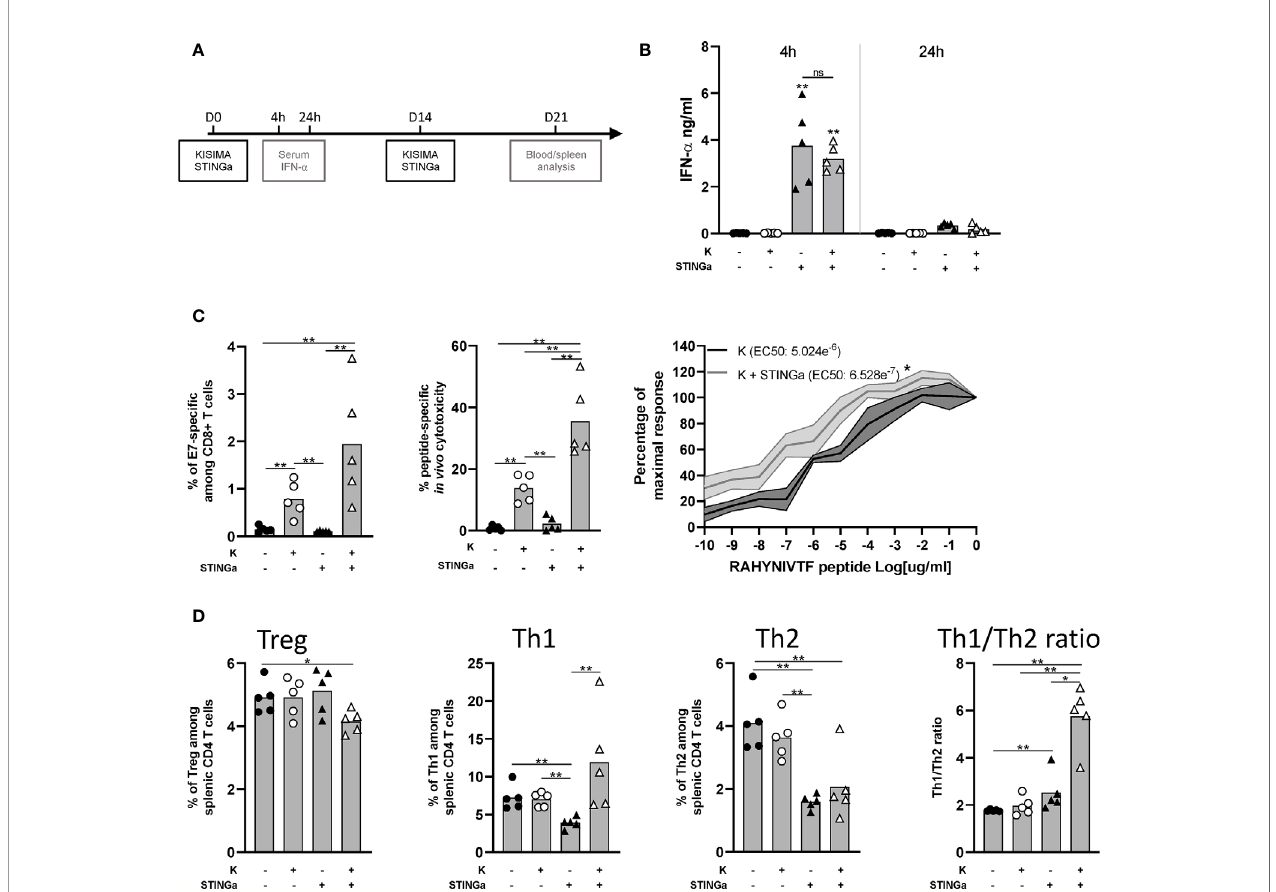
FIGURE 1 | Protein vaccine combination treatment with STING agonist enhances functionality of CD8 T and CD4 T cell peripheral responses in tumor-free mice. C57BL/6 mice were treated with two administrations of Z13Mad25Anaxa vaccine, STING agonist or a combination of the two at two weeks interval. (A) Vaccination schedule. (B) Serum IFN-a level was measured 4 and 24 h post fi rst vaccination. (C) One week after the second vaccination, circulating RAHYNIVTF (HPV-E7)- speci fi c CD8 T cells were measured by multimer staining (left); in vivo cytotoxicity of RAHYNIVTF-speci fi c CD8 T cells was measured by transfer of RAHYNIVTF peptide loaded splenocytes (middle); RAHYNIVTF-speci fi c CD8 T cell TCR avidity was measured by ex vivo ELISpot (right). (D) Frequency of Treg (FoxP3 + ), Th1 (T-bet + ), Th2 (GATA-3 + ) splenic CD4 T cells and Th1/Th2 ratio was measured by fl ow cytometry one week after the second vaccination. (B – D) One representative